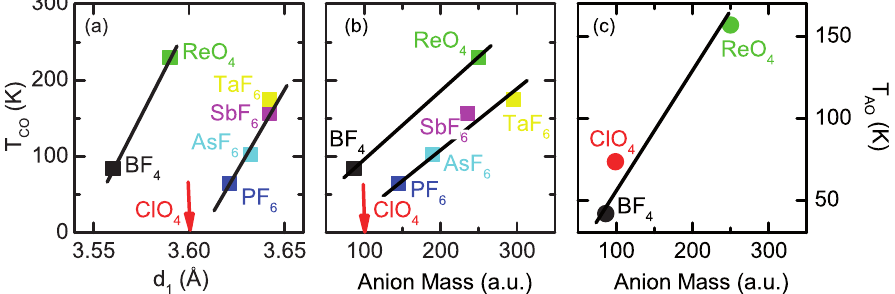
Figure 4. Dependence of the charge order temperature T CO (colored squares) and anion order temperature T AO (colored circles) for various Fabre salts (TMTTF) 2 X with different X as indicated. ( a ) T CO plotted versus the distance between the TMTTF molecules d 1 along stacking direction determined at room temperature. Here, octahedral and tetrahedral salts fall on two different lines. Although the octahedral anions exhibit larger values for d 1 , T CO is lower compared to the tetrahedral salts. The octahedral anions are larger (Table 1) resulting in an increased value of d 1 . The anion-TMTTF stack coupling increases due to the larger anions, and the match between anion and cavity symmetry; thus thermal fluctuations prevail upon the electronic correlations giving rise to CO down to lower temperatures. ( b ) Plot of T CO versus the mass of the anions. A monotonic increase of T CO with anion mass is observed, which is attributed to less effective motion of heavy anions due to thermal fluctuations and, consequently, a less disordered anion potential influencing electronic correlations within the TMTTF stacks. The octahedral and tetrahedral salts fall on two distinct lines due to different coupling between the anions and the TMTTF stacks. ( c ) For the anion ordering temperature observed in the tetrahedal (TMTTF) 2 X salts, an increase of T AO with the anion mass is observed. At a specific temperature, heavy anions are less affected by thermal fluctuations. Consequently, the anion orientation is locked permanently for heavier anions at higher temperatures. As a result, anion order occurs at higher temperatures for heavy